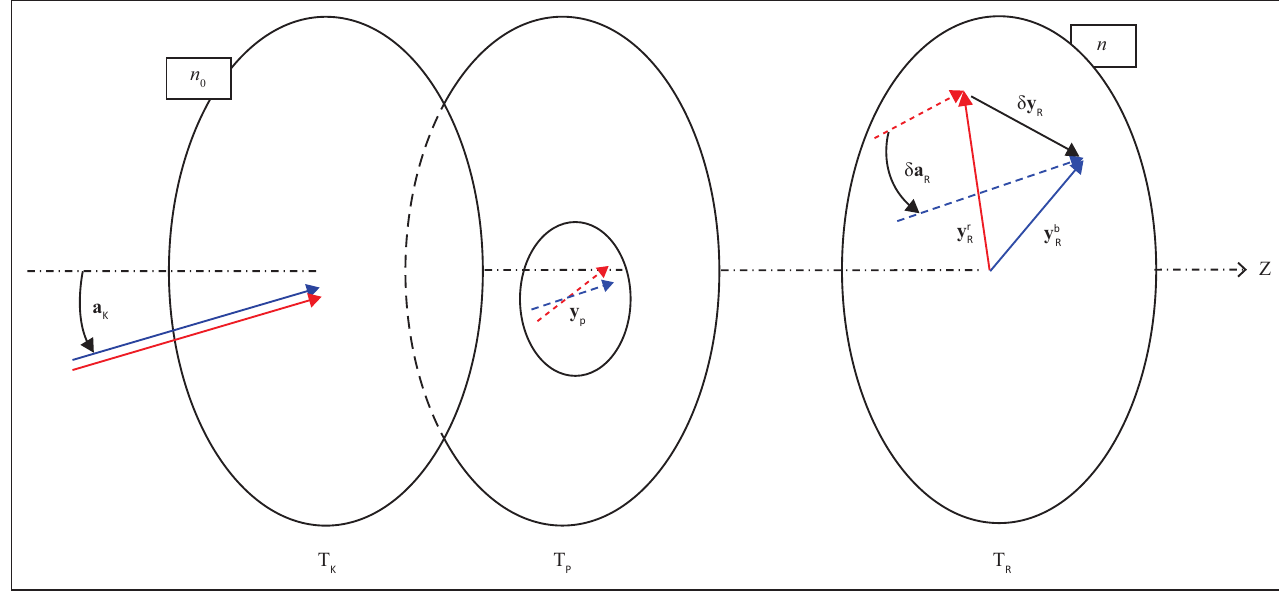
FIGURE 1: A general eye with corneal T select only the red and blue chief rays traversing the centre of the (decentred) pupil y of the red ray Rr y to the blue ray Rb y at the plane of the retina T red ray R r a to the blue ray Rb a . All ray positions, inclinations and pupil decentration are exaggerated for